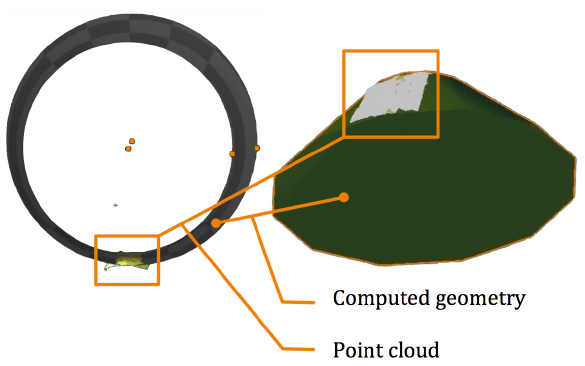
Figure 2: geometric primitives derived from the same cloud point. On the right the shape is aberrant regarding to the cloud, while it correctly matches to the point cloud on the left.